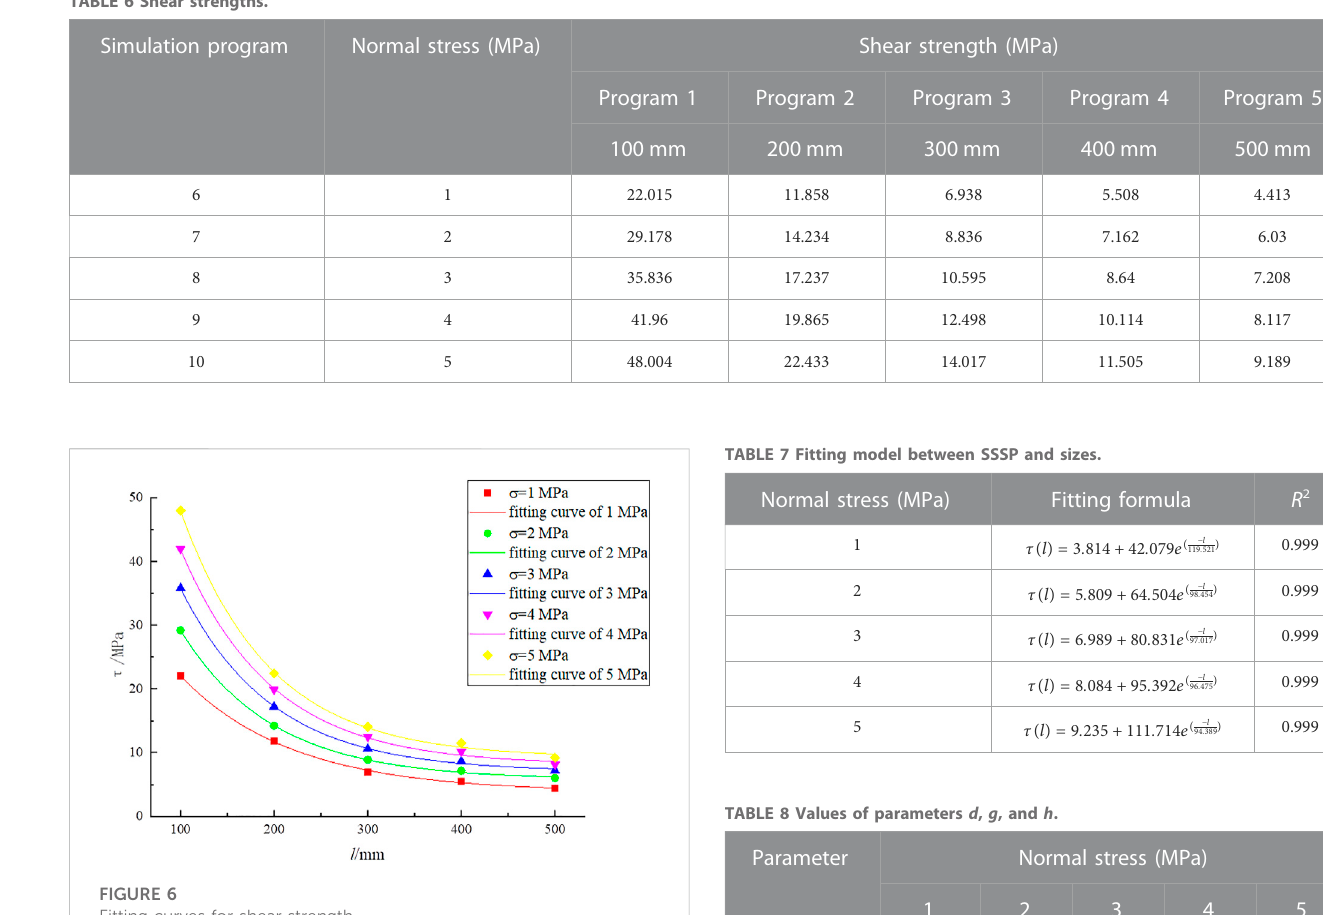
FIGURE 6 Fitting curves for shear strength.